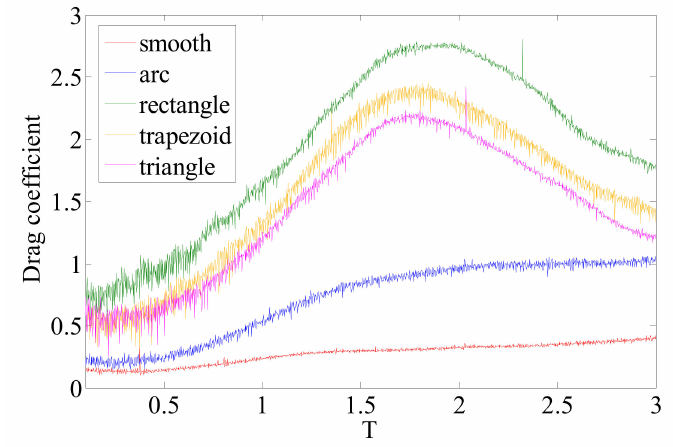
Figure 12. The comparison of the drag coe ffi cients between the smooth cylinder and cylinder with strips of di ff erent shapes for Re =